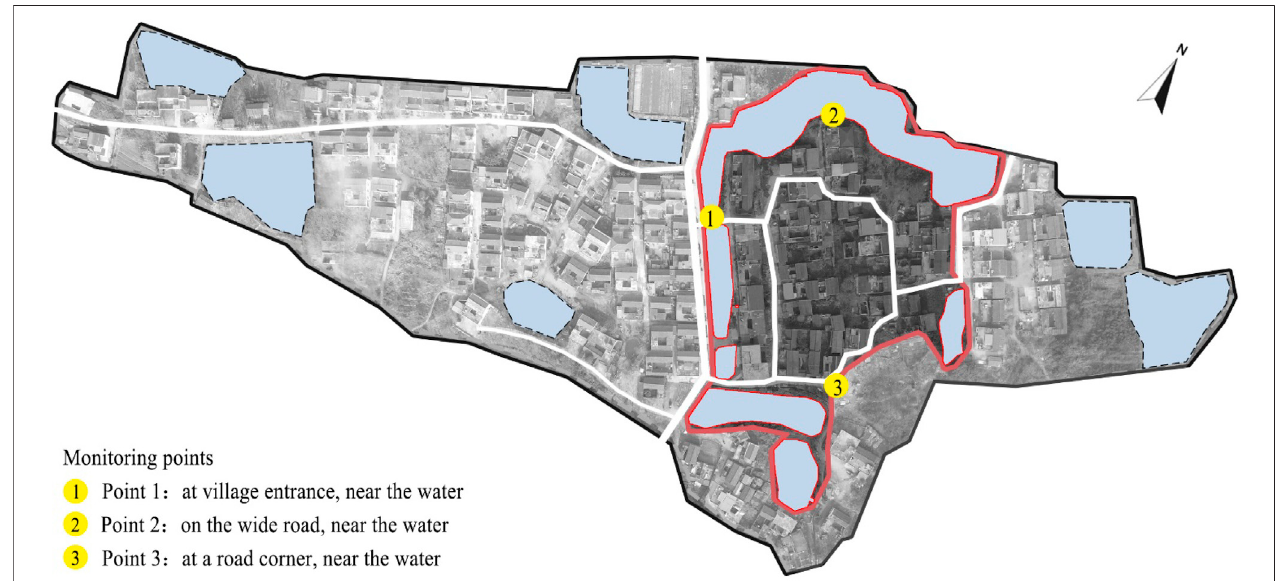
FIGURE 3 | Locations of monitoring points.